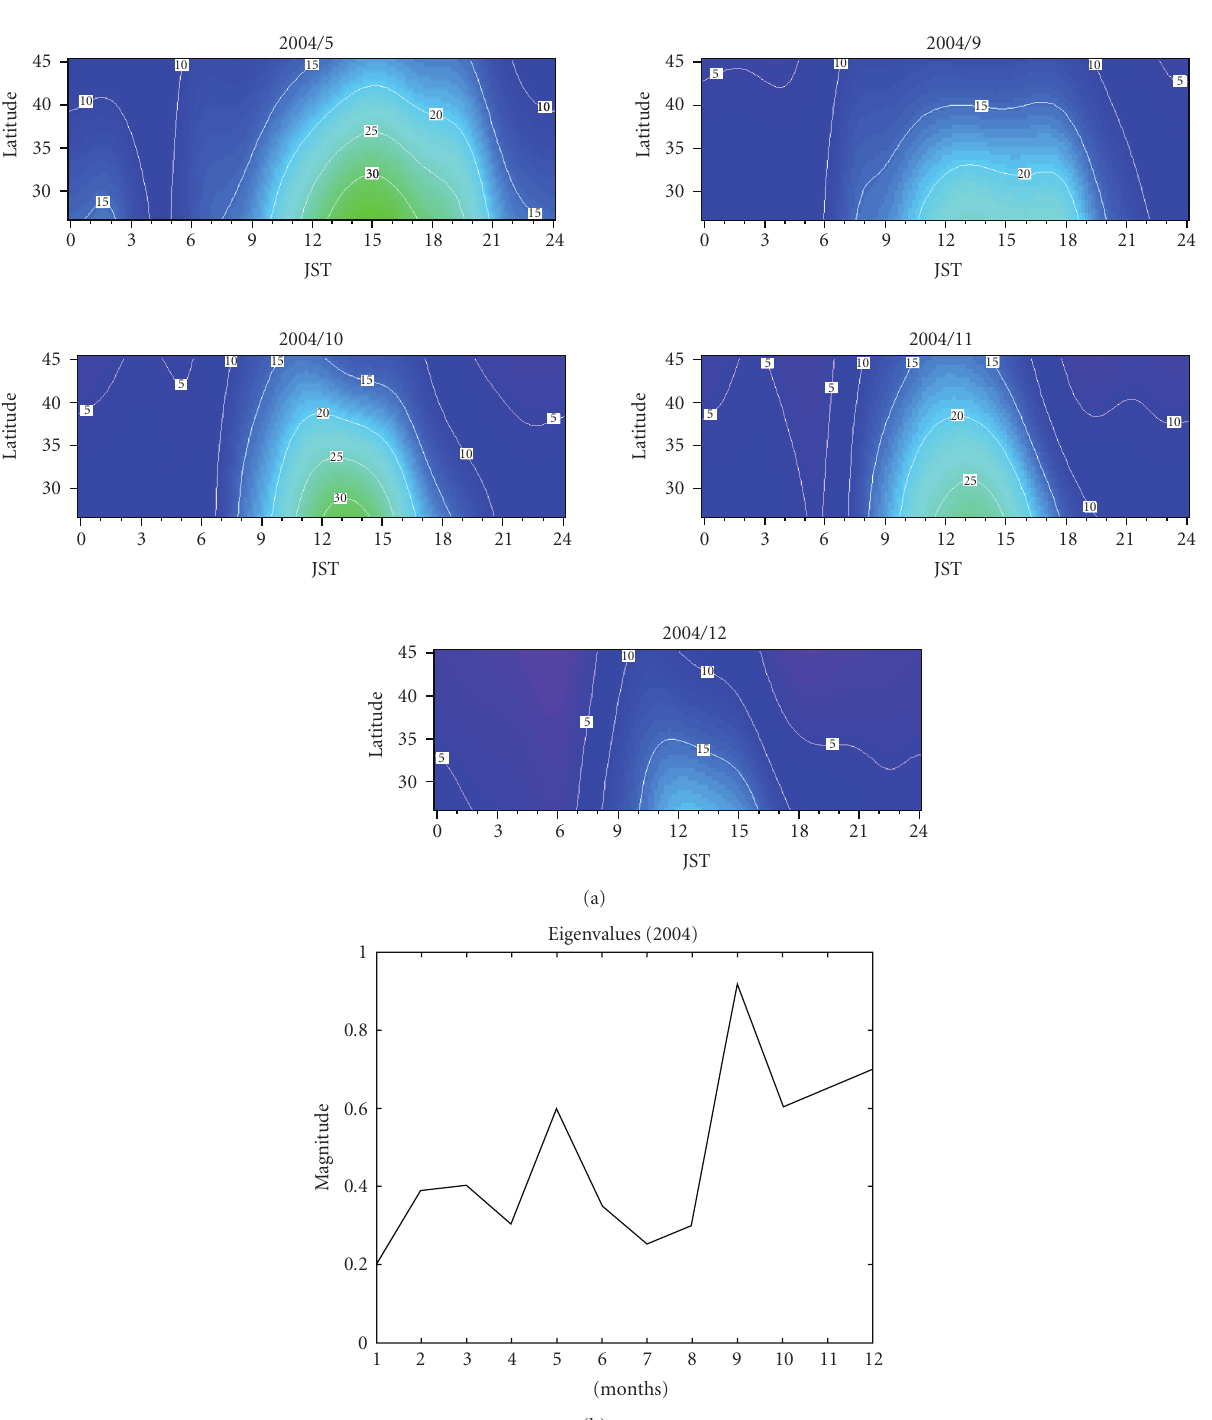
Figure 4: (a) shows the latitude-time TEC records in Japan for 2004 (Unit: TECu). (b) shows 12 principal eigenvalues in 2004. Five larger principal eigenvalues are represented in May, September, October, November, and December in which seven earthquakes occurred on May 29, September 5, September 6, October 23, November 28, and December 6 (Table